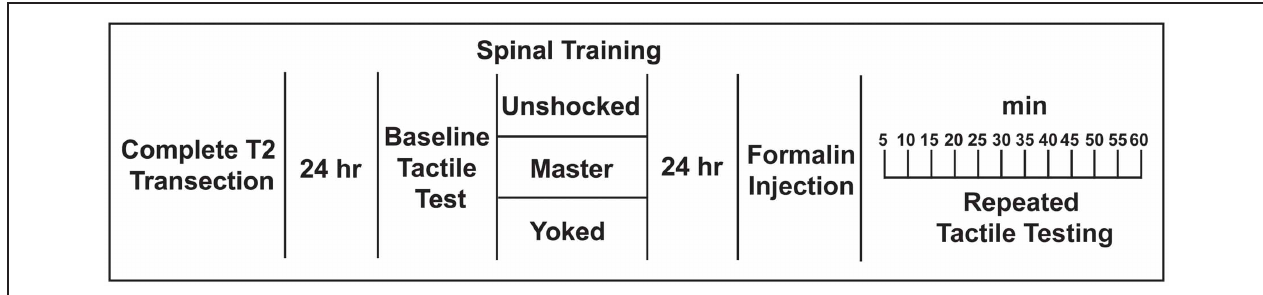
FIGURE 2 | Experimental design used to test whether spinal training history alters future nociceptive responsiveness in the formalin test.